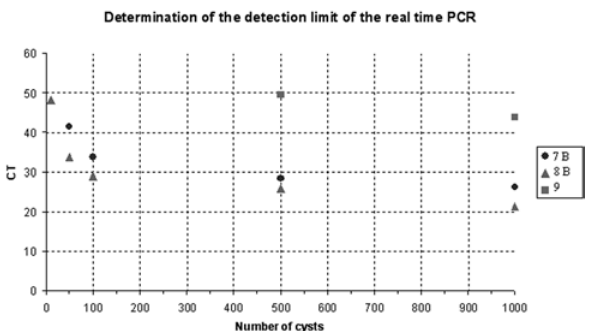
Fig. 3. – determination of the dnA-based detection limit of the real- time Pcr after three protocols: 7 B (3x boiling (100 °c/2 min) and freezing in liquid nitrogen (2 min), QiAamp dnA stool kit, QiAGen, incubation with proteinase 56°c/night), 8 B (boiling – 100 °c/2 min - and freezing in liquid nitrogen - 3x/2 min, QiAamp dnA tissue mini kit, QiAGen, incubation with proteinase 56°c/night), 9 (boiling – 100 °c/2 min - and freezing in liquid nitrogen - 3x/2 min - FastdnA sPin kit for soil, mP Biomedicals; modified protocol. Average of triplicate thresholds cycle (ct) values are presented. standard devia- tion was too small to be